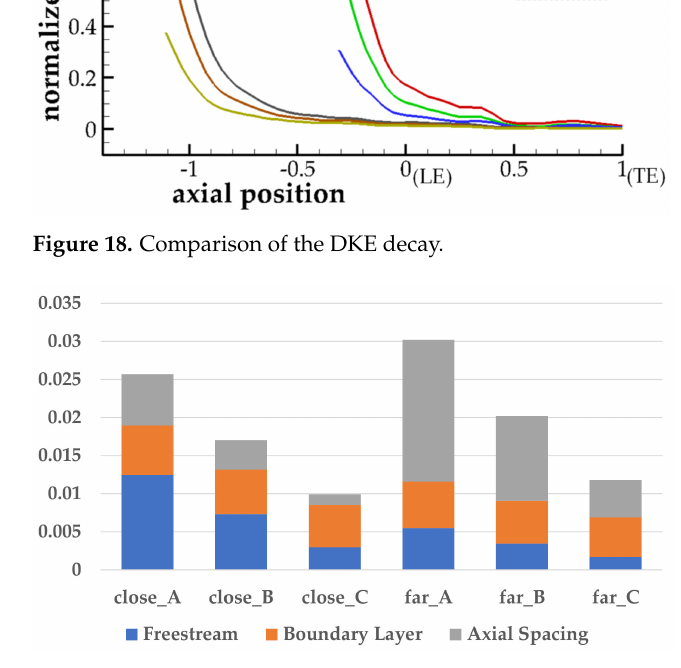
Figure 19. Turbulence eddy dissipation in freestream and boundary